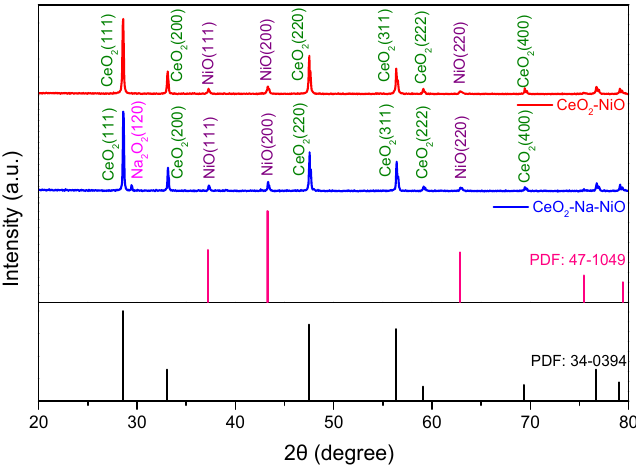
Figure 1. XRD patterns for the prepared CeO 2 -NiO and CeO 2 -Na-NiO.